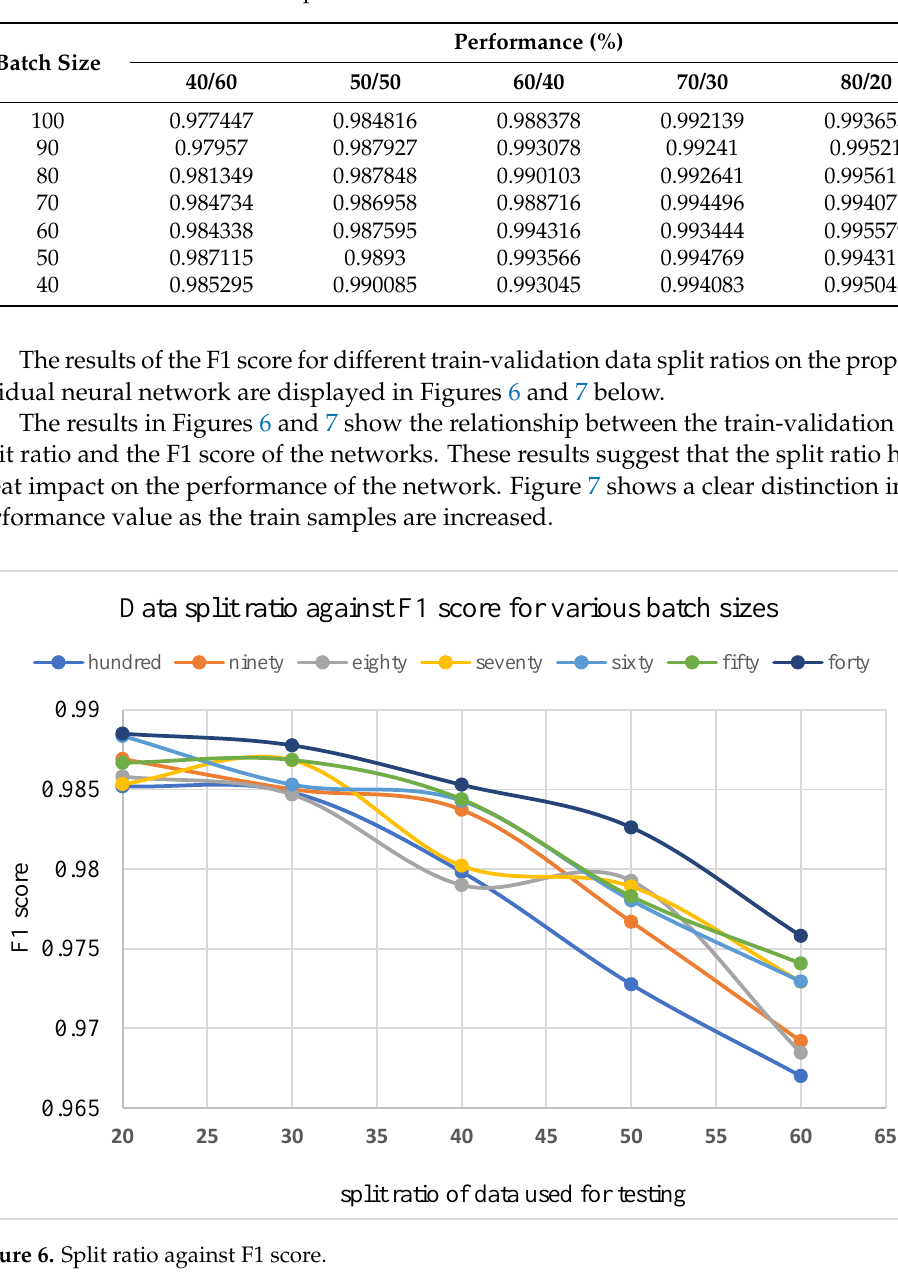
Figure 7. Batch size against F1 score for various validation split ratios. The results in Figures 6 and 7 show the relationship between the train-validation data split ratio and the F1 score of the networks. These results suggest that the split ratio had a great impact on the performance of the network. Figure 7 shows a clear distinction in the performance value as the train samples are increased. For a batch size of 100 images, being the highest batch size value adopted for this research, train set values of 40, 50, 60, 70, and 80% of the entire dataset resulted in a per- formance of 0.9775, 0.9848, 0.9884, 0.9921, and 0.9937, respectively, out of a total value of 1, for a network depth of 152. The results on other network depths also show a similar pattern in performance with such data split ratios. This suggests that a split ratio of 80/20 is a good choice for plant leaf image recognition.